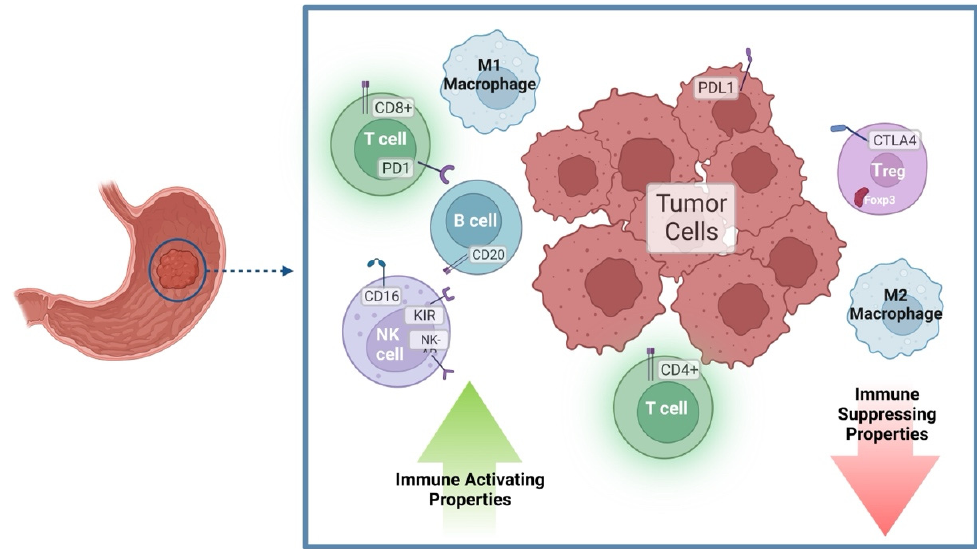
Figure 1. Infiltrating immune cells balance the inflammatory vs. immuno-suppressive tumor microenvironment (TME) in GC. CD8+ T cells are generally cytotoxic to tumor cells, although the tumor may evade the immune system via PD-1/PD-L-1 signaling. CD4+ T cells may differentiate into T helper subtypes with pro-inflammatory properties. However, differentiation into Treg with CTLA4 expression will drive an inhibition of immune cell activity. B cells are generally thought to have anti-tumor immune activating functions. M1 macrophages are pro-inflammatory and drive immune activation in the TME, while M2 macrophages decrease immune responses. NK cells may have anti-tumor properties which can be inhibited by tumor-secreted factors. Figure created with BioRender.com (accessed on 25 October